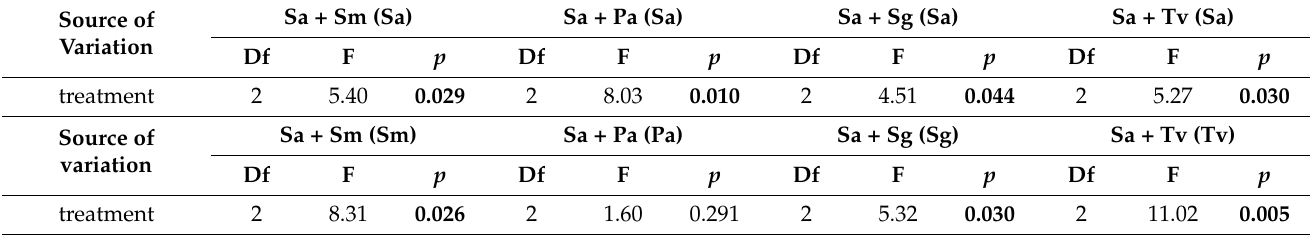
Table 2. Results of one-way ANOVA testing the effects of interspecific interaction treatment on the mean time to seed germination of invasive Spartina alterniflora (Sa) and four native species ( Scirpus mariqueter , Sm, Phragmites australis , Pa, Suaeda glauca , Sg, and Tripolium vulgare , Tv) in different species combinations. The abbreviations in brackets after species combinations denote the target species considered. Significant p values are in bold.